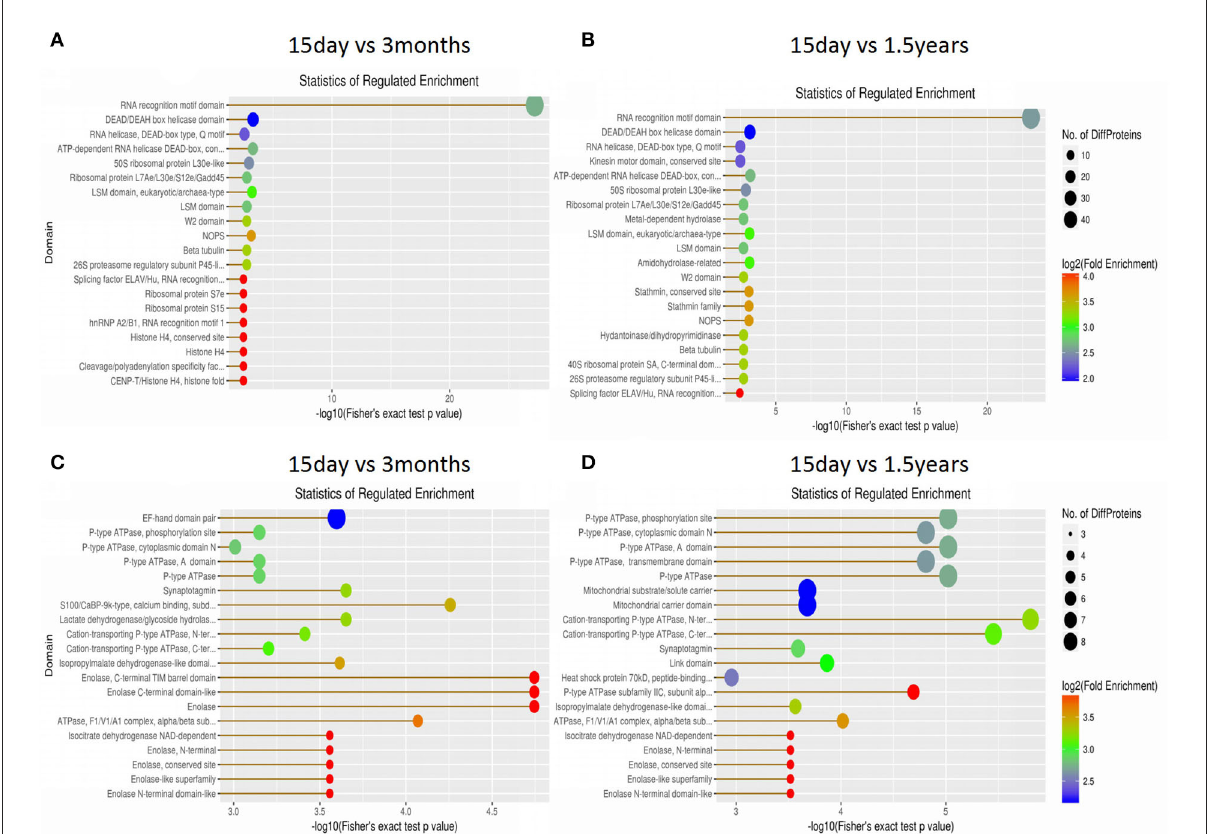
FIGURE7 Domain enrichment analysis of differentially expressed proteins. Each solid circle is a domain, and a horizontal coordinate represents a significant p -value of domain enrichment, which is –log10. The larger the value is, the more enriched it is. The ordinate represents the name of the domain class. The size of the solid circle represents the number of different proteins under the domain classification, and the larger the circle is, the more different the proteins are. The color of the solid circle indicates the enrichment multiple of the domain classification, and the redder the color, the greater the enrichment multiple. (A) The upregulated protein domain enrichment in the 15-day and 3-month age groups. (B) The upregulated protein domain enrichment in the 15-day and 1.5-year age groups. (C) The downregulated protein domain enrichment in the 15-day and 3-month age groups. (D) The downregulated protein domain enrichment in the 15-day and 1.5-year age groups.